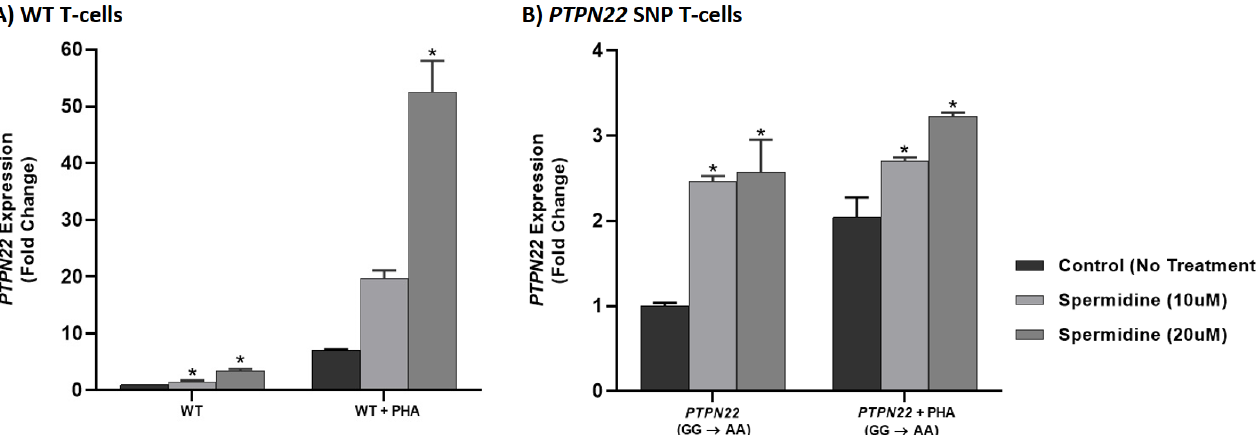
Figure 6. Effect of Spermidine on PTPN22 Expression in WT and PTPN22 SNP Jurkat T-cells Stimulated with PHA ( n = 3). RT-PCR was used to measure expression of PTPN22 in ( A ) WT and ( B ) PTPN22 SNP T-cells stimulated with PHA (10 µg/mL) and treated with spermidine (0, 10, 20 µM). Significance among experiments was assessed by one-way analysis of variance (ANOVA) followed by Tukey’s multiple comparison test and cross checked with Wilcoxon matched-pairs test for non-parametric tests. * p < 0.05 compared to unstimulated or untreated cells for each cell type.